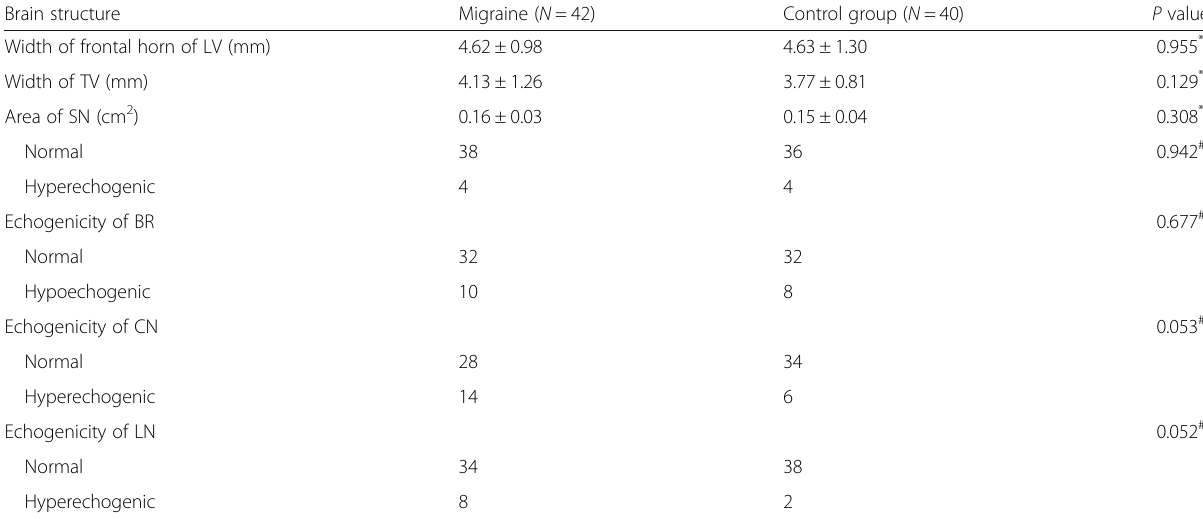
Values are given as mean±standard deviation or exact number. # chi-square test, * t-test. LV lateral ventricle, TV Third ventricle, SN Substantia Nigra, BR brain raphe, CN Caudate nucleus, LN Lentiform